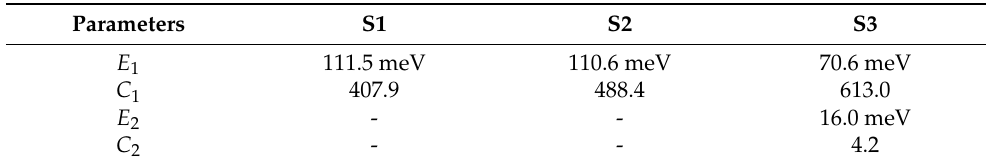
Table 1. The values of fitted Arrhenius parameters for samples S1, S2 (one channel), and sample S3 (two